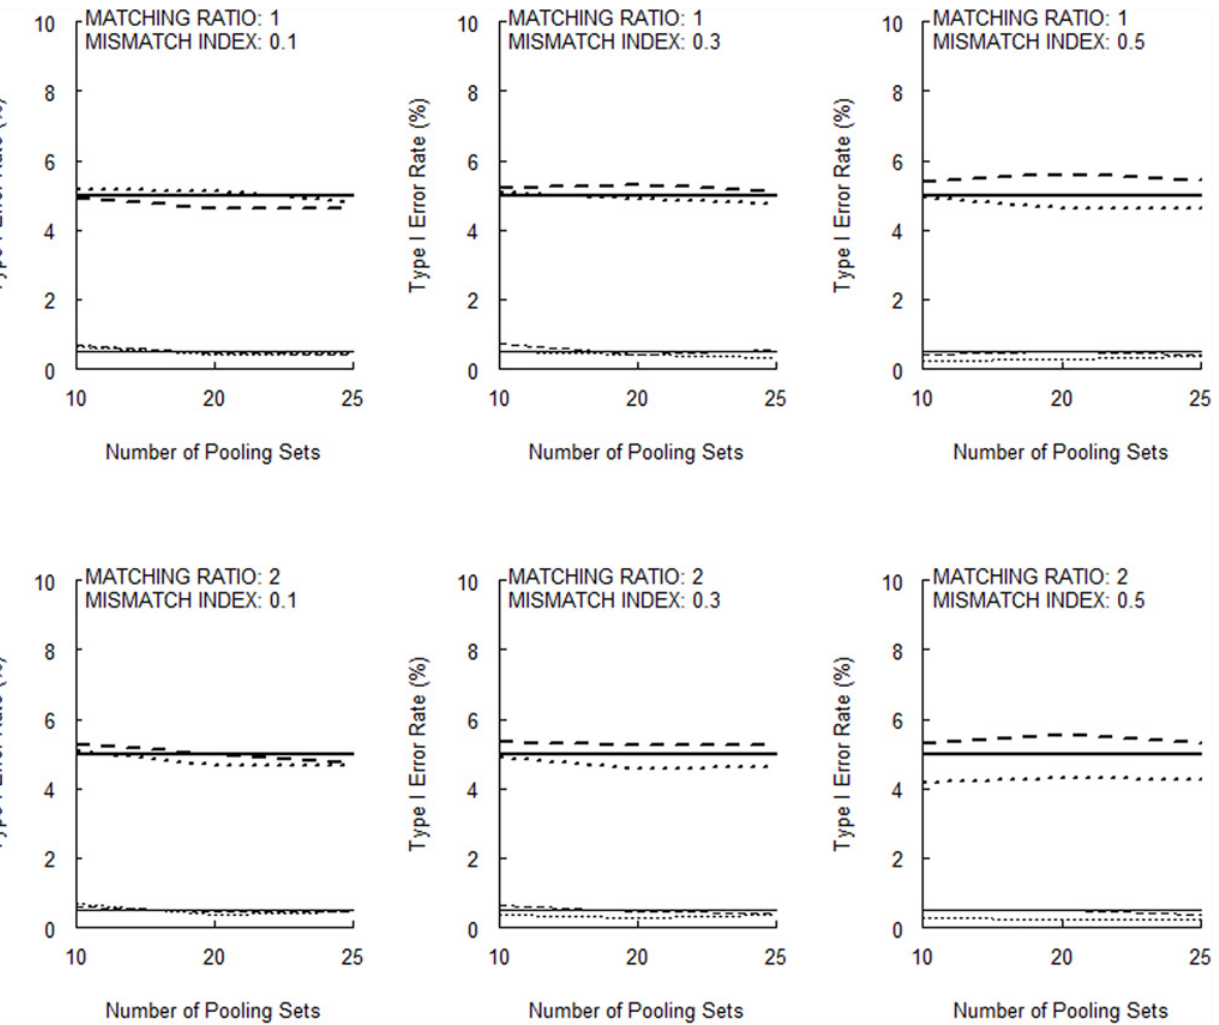
Fig 1. Type I error rates of the permutation test with a total of 10 null markers (bold broken lines, σ = 0.05, α = 0.05; thin broken lines, σ = 0.05, α = 0.005; bold dotted lines, σ = 0.01, α = 0.05; thin dotted lines, σ = 0.01, α = 0.005). The horizontal bold and thin solid lines indicate the nominal α level for α = 0.05 and α = 0.005,